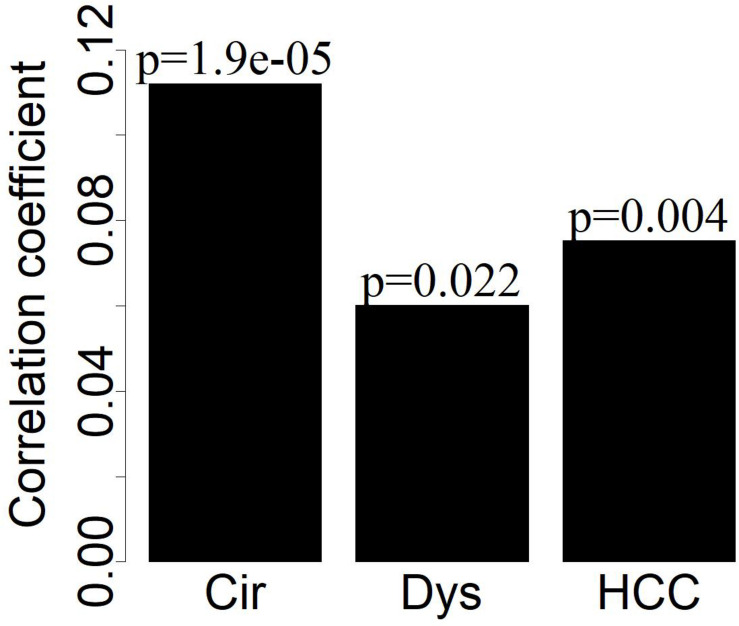
The deviation of LMGs from controls in their expression (| logFC|) has weak positive correlations (Pearson correlation) with the connectivity of LMGs.